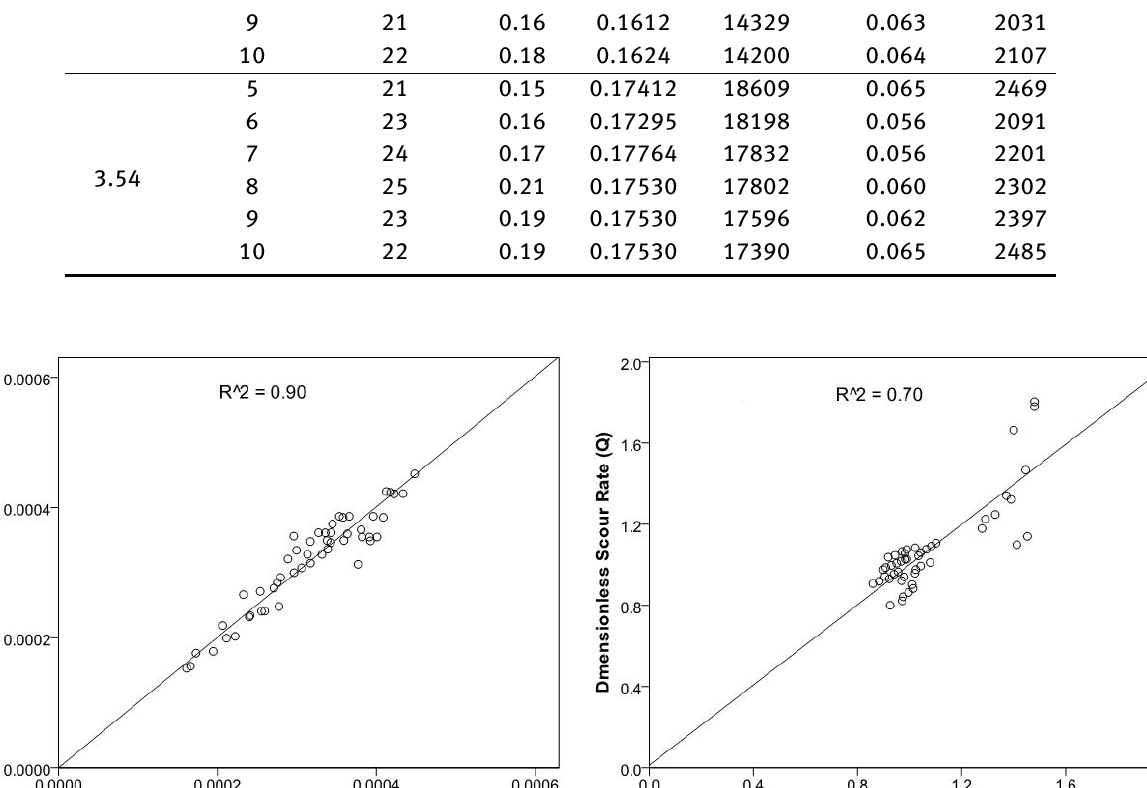
Figure 10: Relationship of dimensionless scour rate with dimension- less share stress and soil protrusion in rough